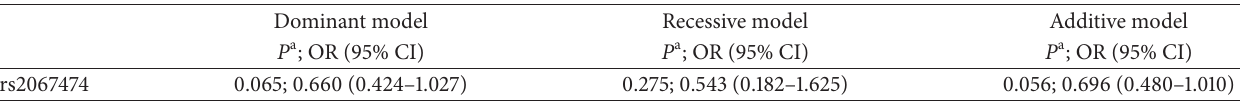
Table 3: Multivariate analysis for HRH2 rs2067474 polymorphism and risk of breast cancer according to dominant, recessive, and additive genetic models.